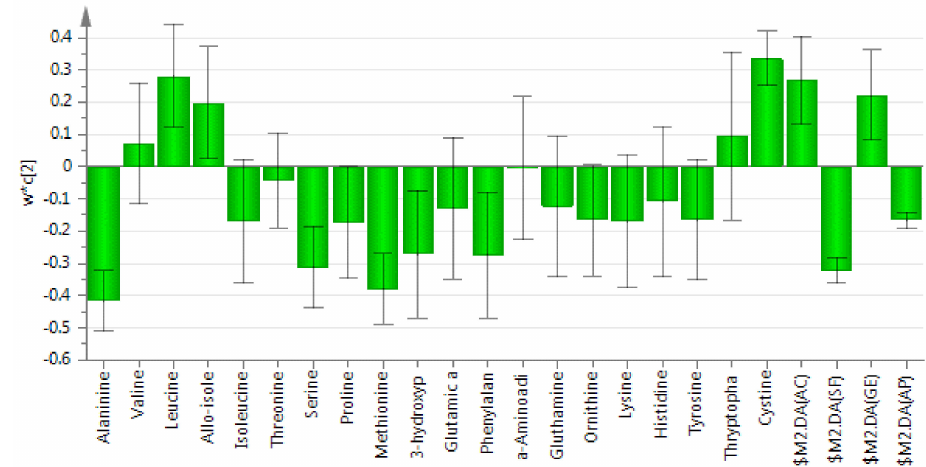
Figure 4. The Partial Least Squares-Discriminant Analysis (PLS-DA) loading column plot of amino acids in honey samples from di ff erent botanical origins. AC = acacia honey, SF = starfruit honey, GE = gelam honey and AP = Apis honey.